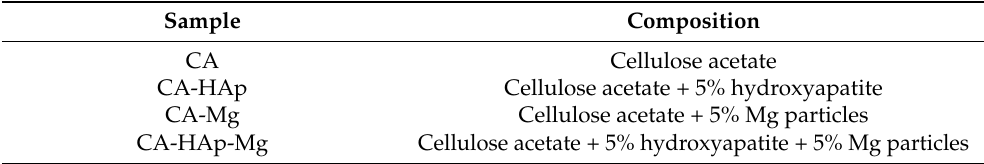
Table 3. Composition of the elaborated samples.